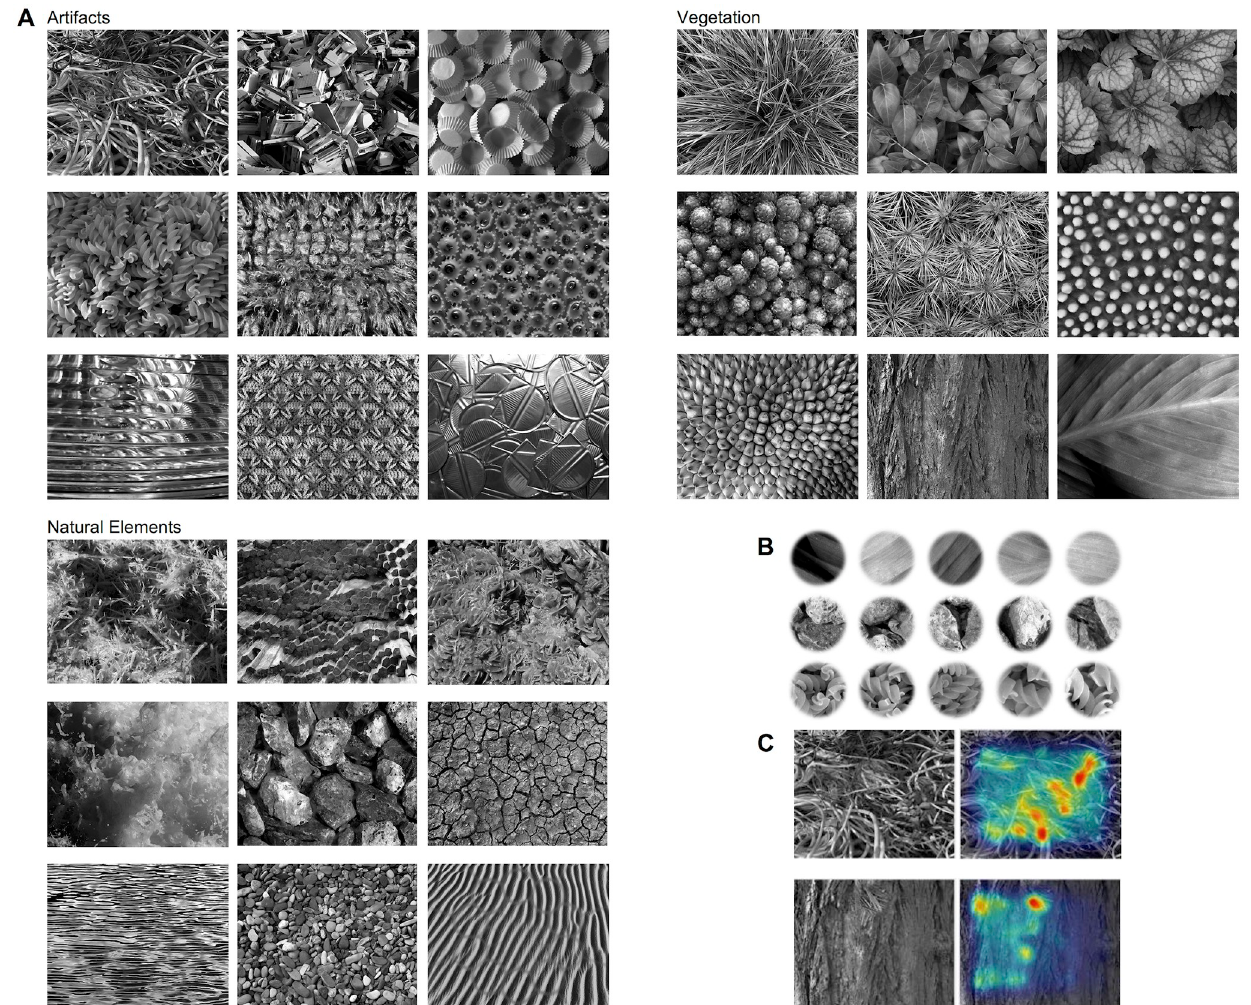
Fig 1. Creation of the search stimuli used in the study. (A) The 27 images used in this study, grouped by category, in the format in which they were used as backgrounds in the search task. Within each category, the images are arranged left to right according to decreasing values in rated depth. (B) Examples of the five target patches sampled from each of the 27 images. Targets could appear at one of 10 possible target locations, see Fig 2. (C) Stimuli with moderate target salience were created by placing different target samples at each of the 10 locations, respectively, and comparing the results with a salience algorithm (GBVS; [113]). Targets that were salient (indicated in the two examples by orange to red overlay) without being the only salient region of the stimulus at the respective location were selected. The 261 stimuli identified through this process were converted to three monochromatic colors (green, blue, red) each. From this set, we produced the eight versions of the experiment with 36 test trials each following these restrictions: The stimuli (i) were balanced over target and background categories, (ii) were balanced over the crossed factors category- and depth-congruency, and (iii) no image should appear more than twice as either target or background in any of the eight versions. Taken together, the eight versions of the full experiment included 288 test-trials. The resulting frequencies of the defining factors in these trials are reported in S1 Table in S1